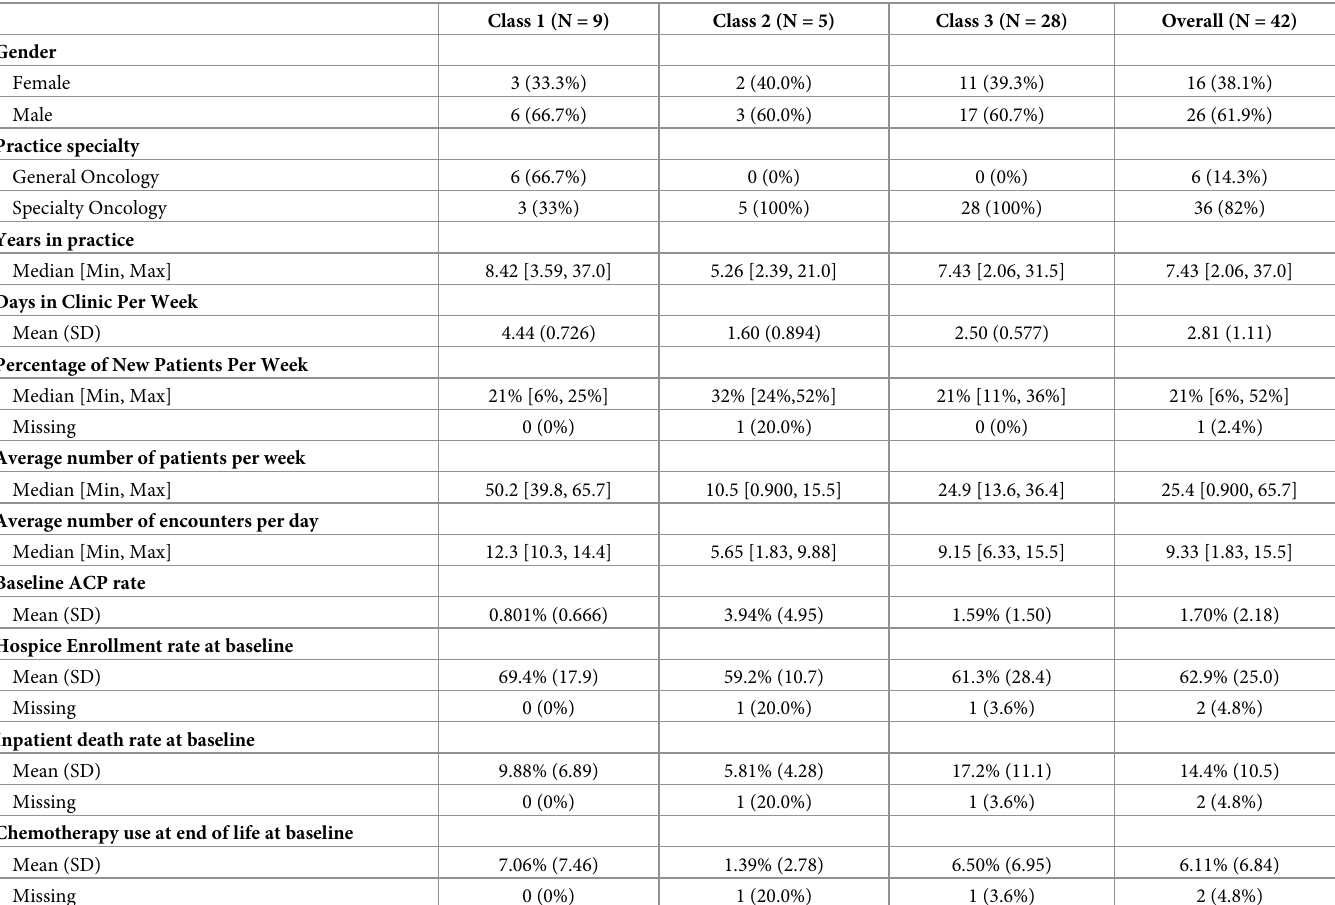
Table 1. Demographic and practice characteristics of oncologist